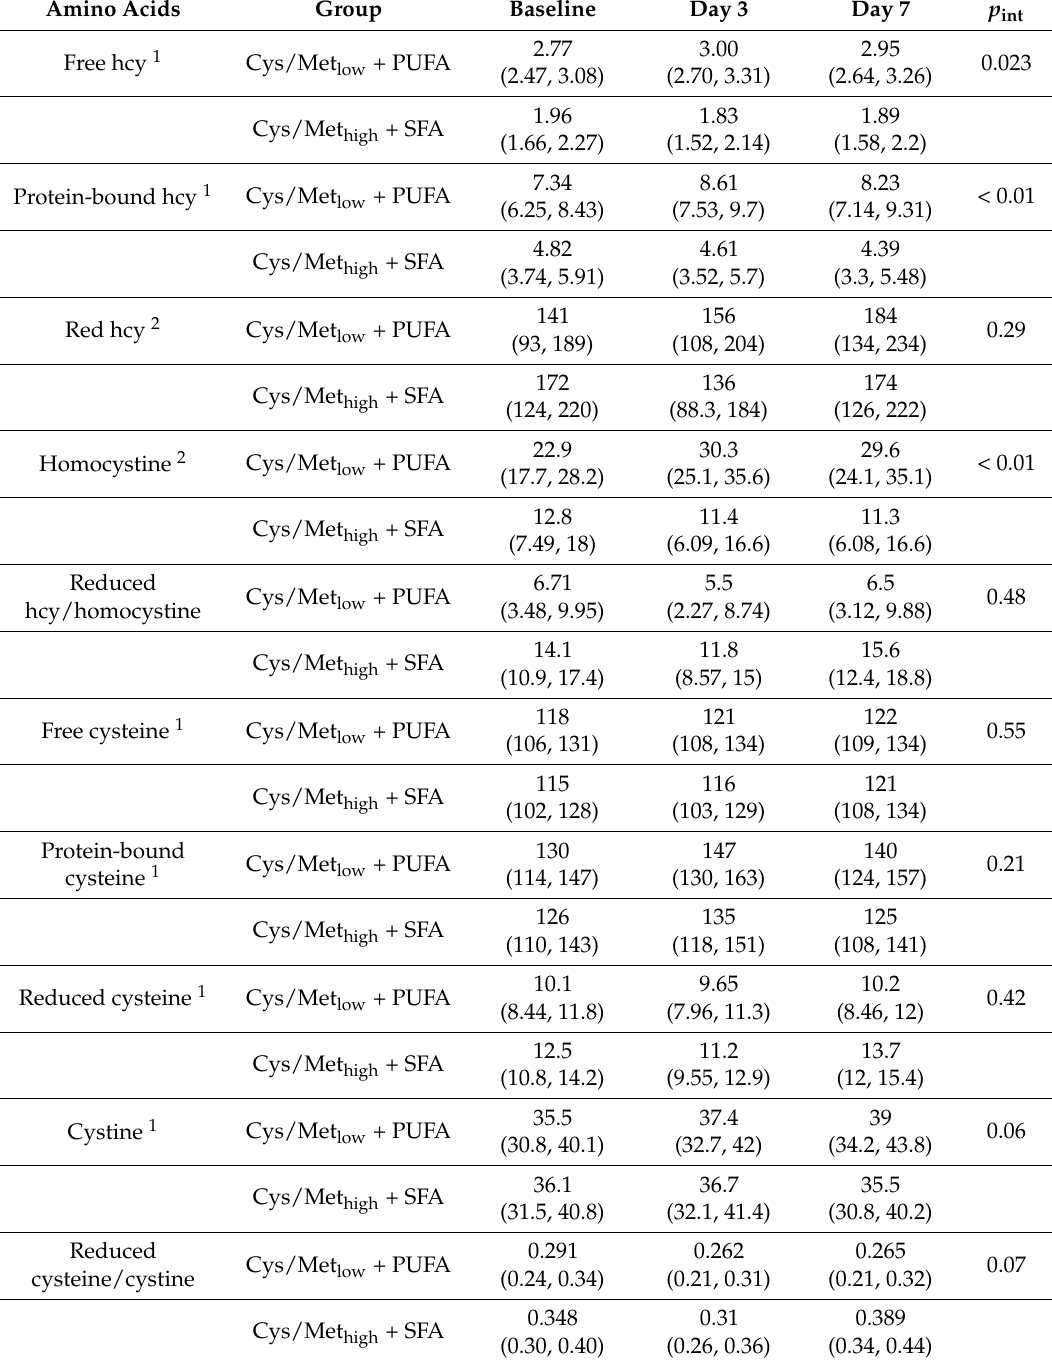
Table 3. Estimated marginal means (95% confidence interval) of fractions of total homocysteine and total cysteine in